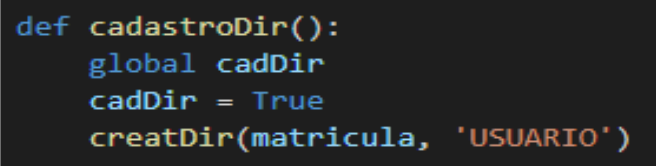
Figure 10: Function invoking "creatDir" for folder creation.